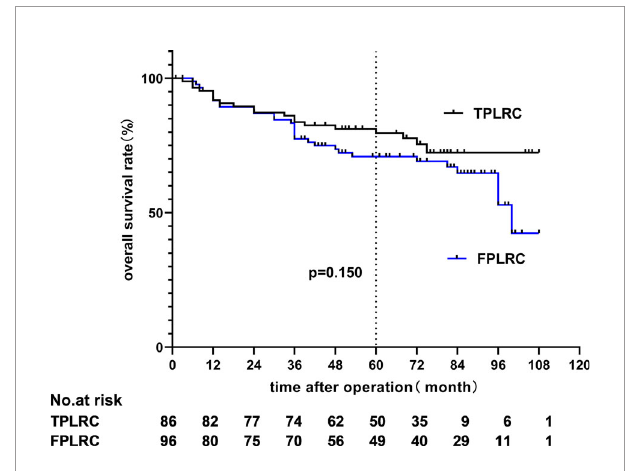
FIGURE 4 | Overall survival rate.